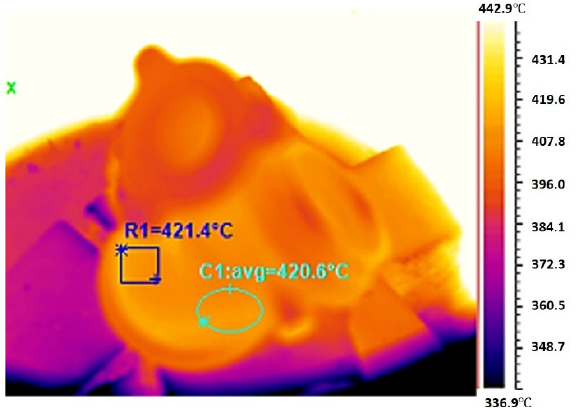
Figure 4. Turbine housing at 420 °C and an emissivity of 0.92.